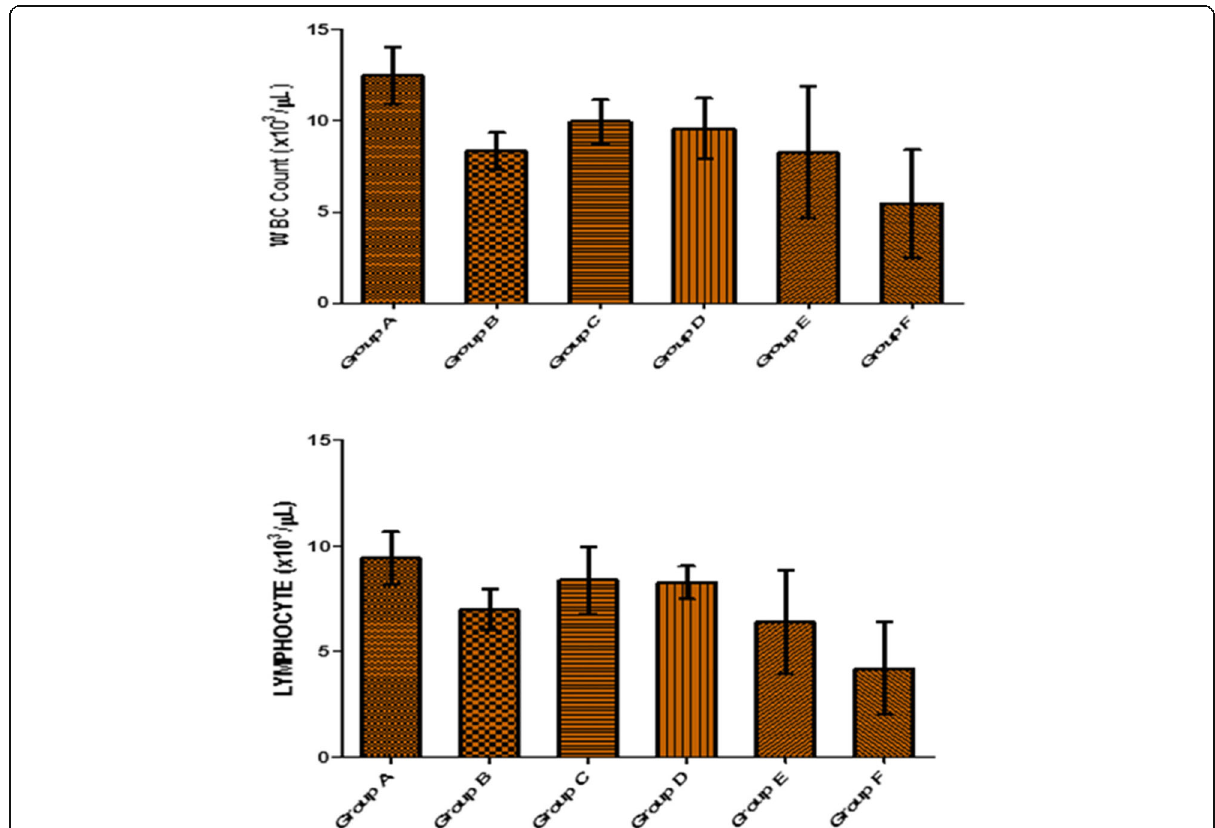
Fig. 5 Bar-charts showing the total WBC (White Blood Cell) count and Lymphocyte count following the administration of Spondias mombin extract and PHZ at different